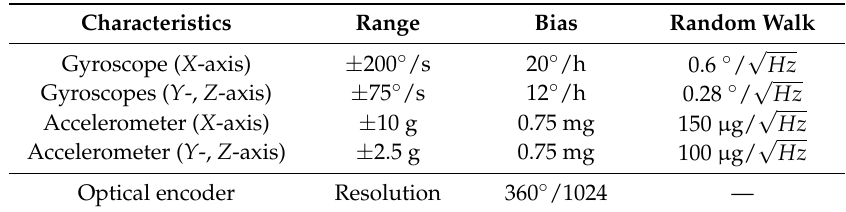
Table 3. Parameters of the sensors in